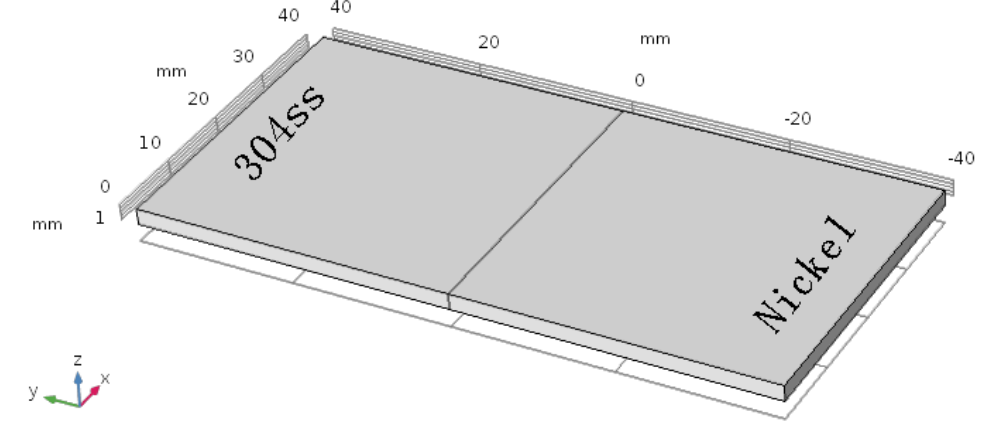
Figure 1. The shape and size of the specimen used in the experiments. Table 1. Chemical compositions of Ni and 304ss (automatic fraction (%)).